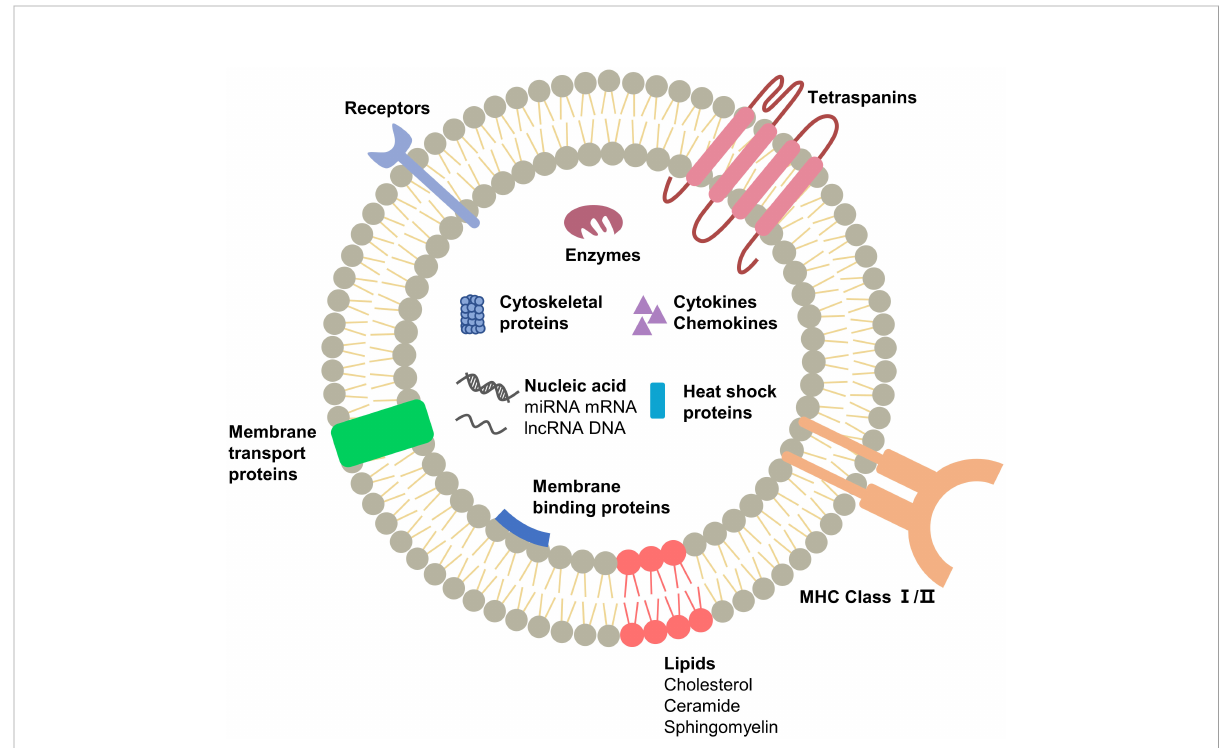
FIGURE 1 Schematic representation of exosome composition. The main substances are proteins, nucleic acids and lipids, which are the structural and functional basis of exosomes. The components in exosomes secreted by different cells may